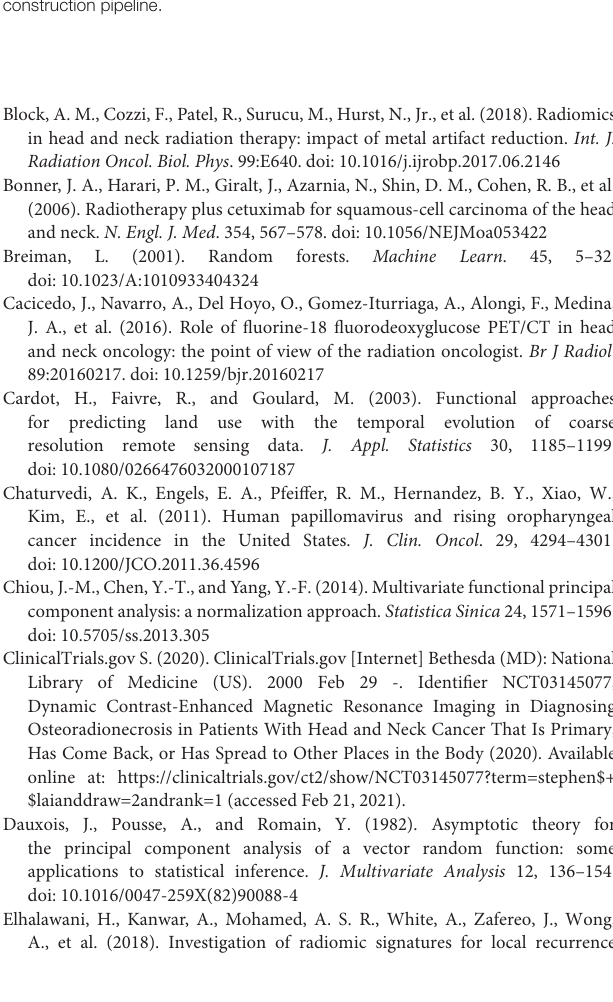
Supplementary Figure 1 | ROC curve for the FPCA-based temporal trajectory model with optimal operating point. The optimal operating point of the ROC curve is identified by maximizing the Youden’s index. The corresponding sensitivity and specificity values for the optimal operating point are shown. Supplementary Figure 2 | Confusion matrix for the ORN prediction task at the optimal operating point. The confusion matrix showing the classification performance by the FPCA-based temporal trajectory model at the optimal operating point of the ROC curve. Supplementary Table 1 | Computed tomography- derived intensity histogram, shape and texture analysis features set. Supplementary Table 2 | Filtered radiomic feature set. The final set of 16 features chosen after correlation filtering, which are used for building baseline, delta, and FPCA